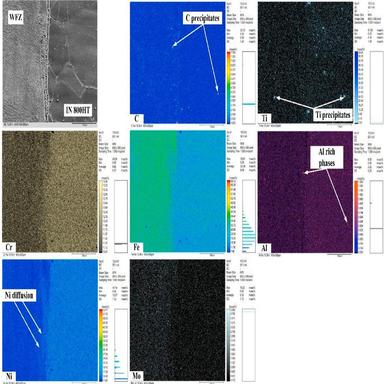
EPMA qualitative analysis of IN 800HT weld interface.